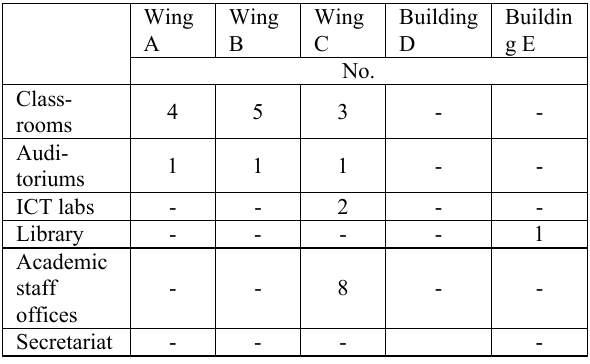
Figure 4. Secretariat path.